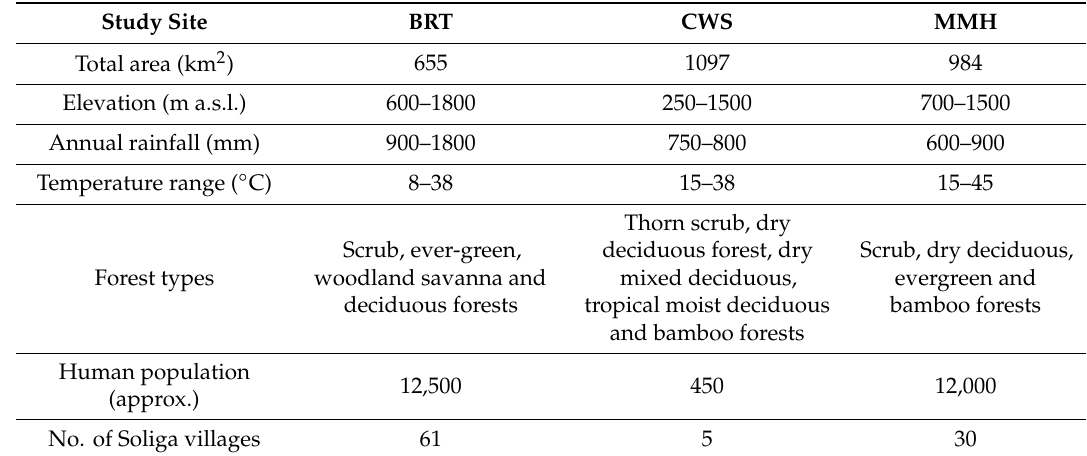
Table 1. Summary study site attributes of the three study protected